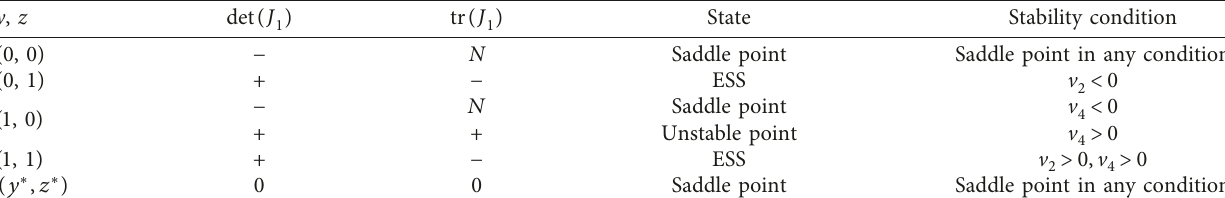
Table 3: Local stability analysis between external investors and SMEs.